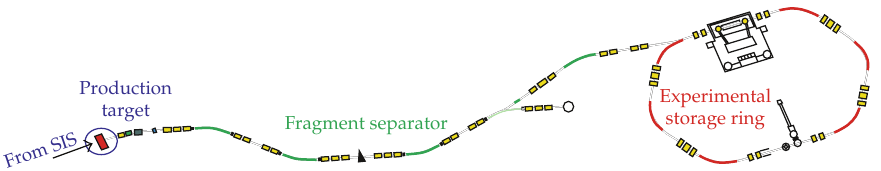
Figure 4: Part of the accelerator facility of GSI, relevant for the proposed measurement of the bound-beta half-life of bare 205 Tl 81 (cid:4) ions. A beam of 206 Pb ions, accelerated in the synchrotron SIS to an energy of some 100AMeV, hits the production target (cid:2) Be (cid:3) of the fragment separator FRS, where a plenty of highly-charged ions will be generated by nuclear reactions. With the aid of an appropriate setting of the FRS magnets and by exploiting the Z -dependent stopping power in a degrader placed in the symmetry point of the FRS (cid:2) black triangle (cid:3) , only bare 205 Tl 81 (cid:4) ions can pass through small slits at the end of the FRS. Those ions will be stored in the experimental storage ring (cid:2) ESR (cid:3) and accumulated by repeated injections until a number of at least 10 6 ions will be reached. After the application of electron cooling, the 205 Tl 81 (cid:4) ions are circulating in the ring for a couple of hours, where a few of them will decay to hydrogen-like 205 Pb by bound-state β